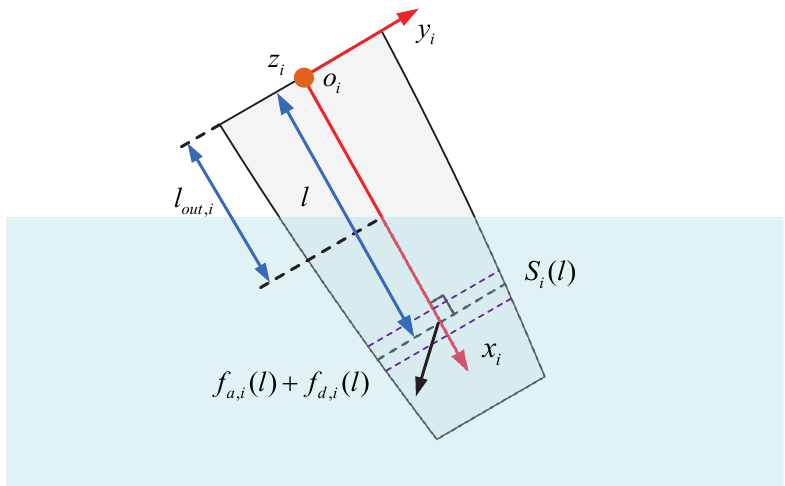
Figure 4. Illustration of the hydrodynamic forces exerted on i th link L i with an exiting length of l out , i